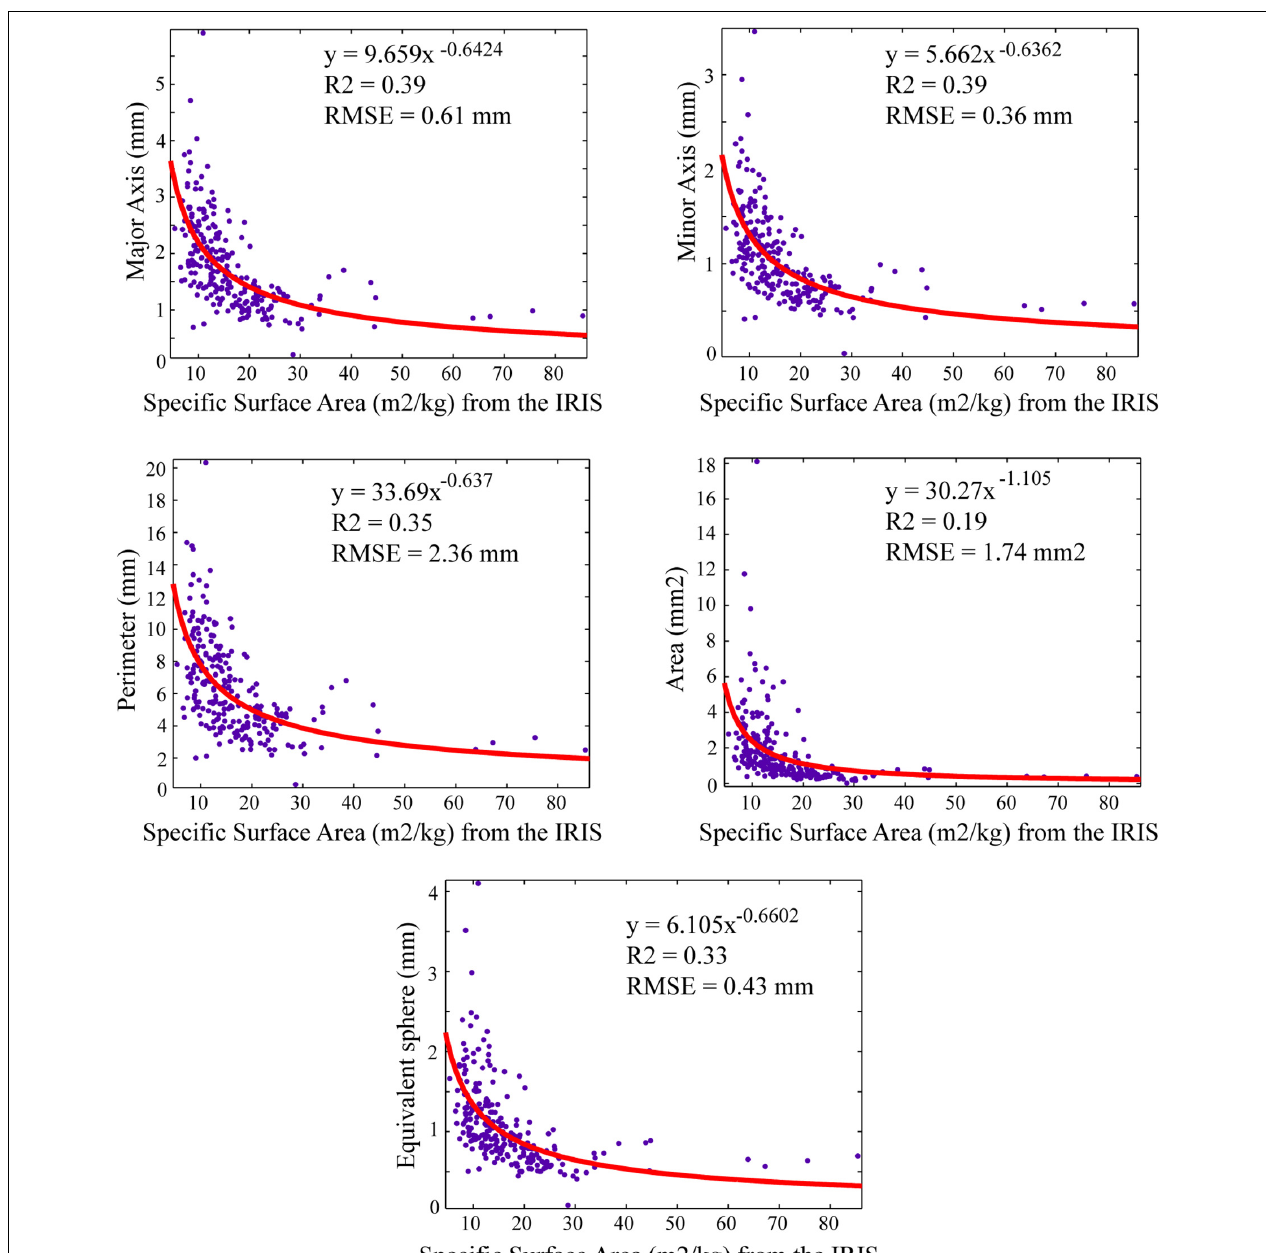
FIGURE 9 | Measured SSA values compared with: Major axis, Minor axis, Perimeter, Area, and Equivalent sphere computed from the dLED.